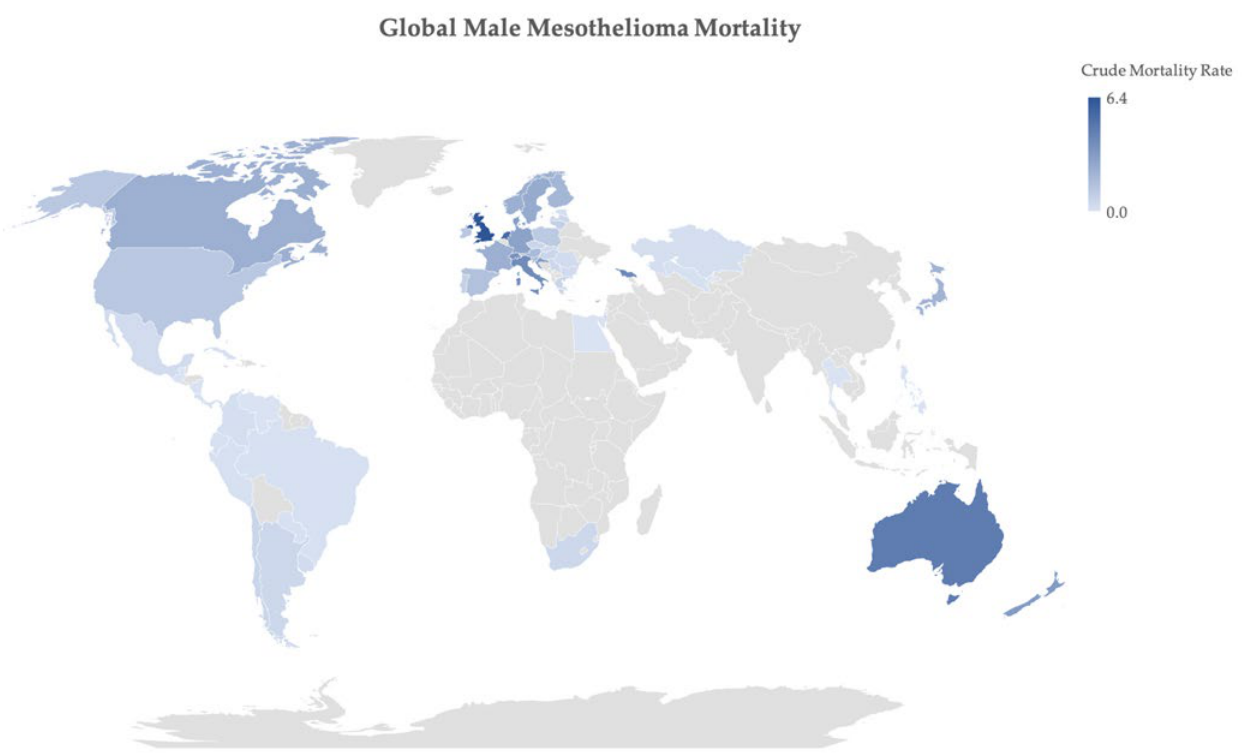
Figure 1. Global male mesothelioma mortality up to 2017, expressed as crude rate per 100,000; source: World Health Organization mortality database